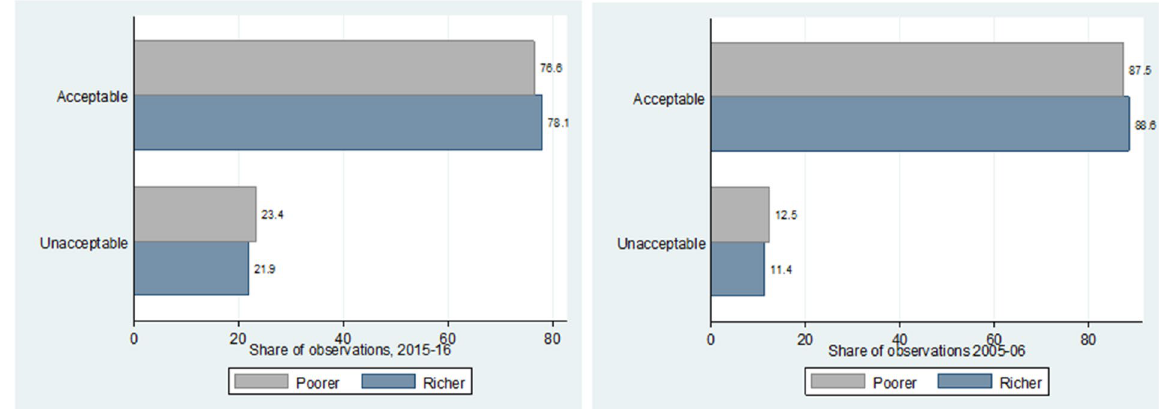
Figure 8. Variation in data quality for Indian states based on their wealth.